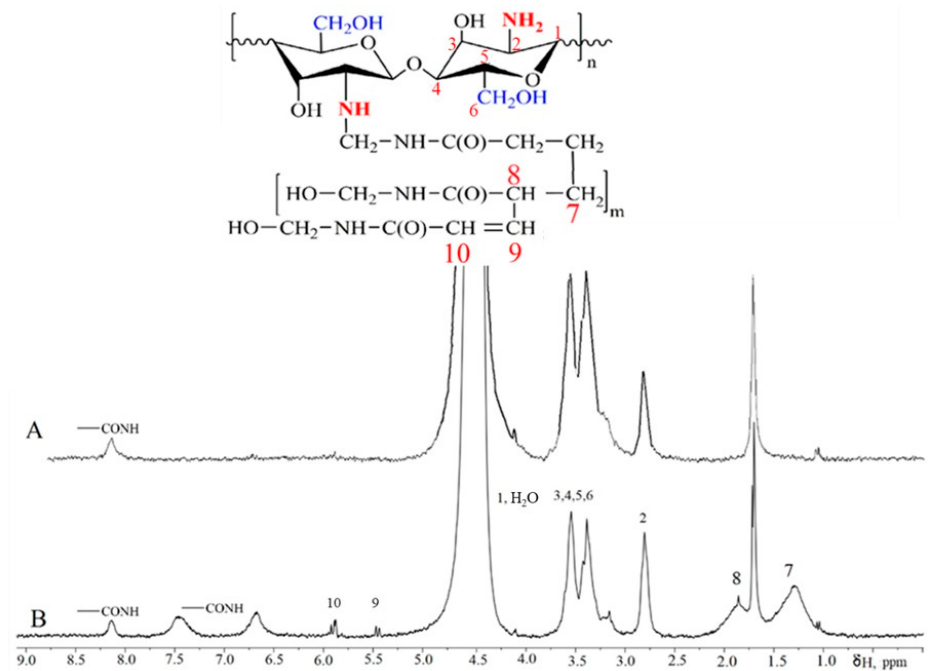
Figure 6. 1 H NMR spectra of pure chitosan ( A ); soluble fraction of the irradiated samples ( B ).